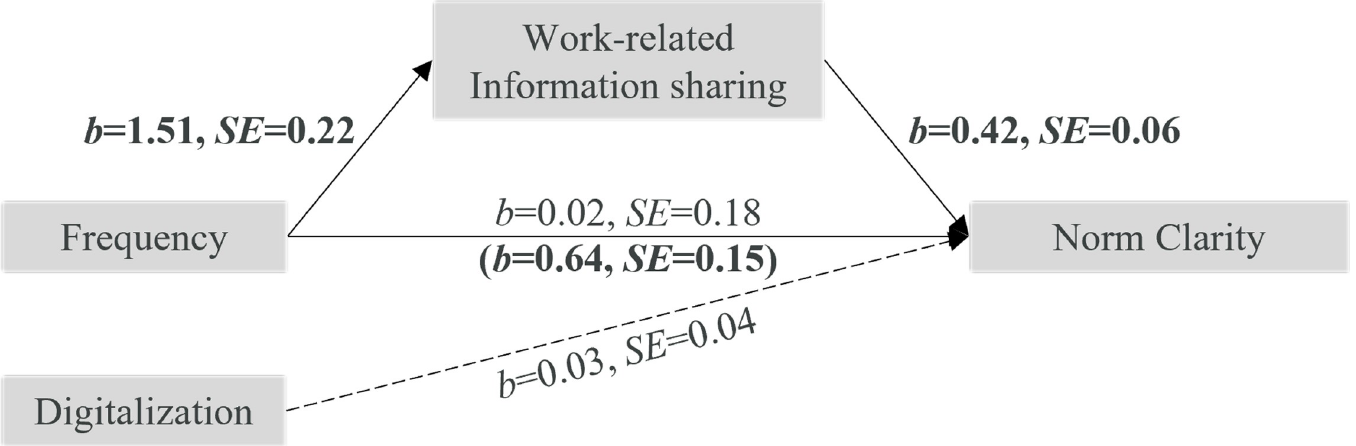
Fig 4. Mediation analysis with outcome norm clarity. Estimates in bold are significant, dashed line represents control variable.